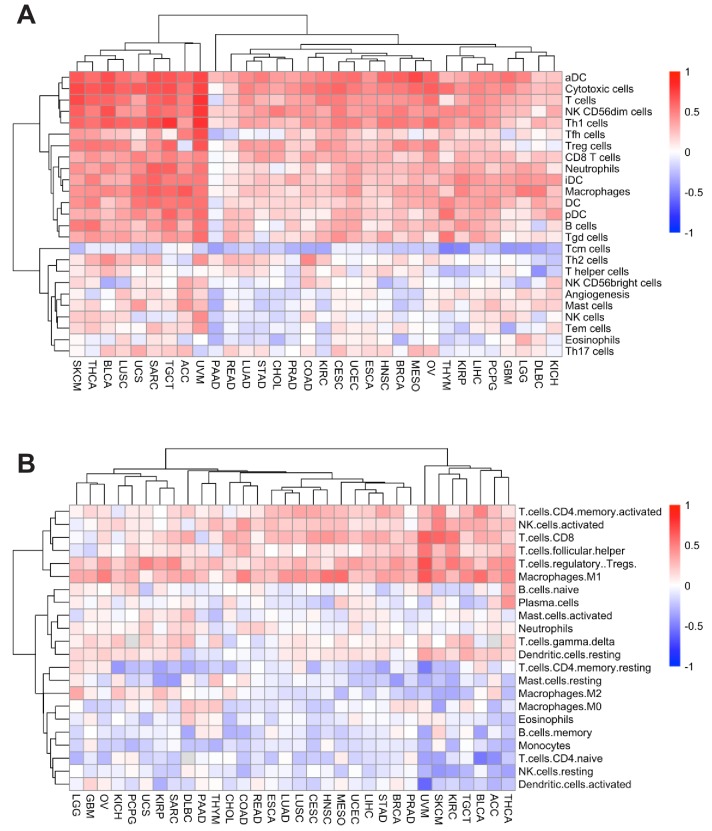
Immune cell subsets associated with APS were analyzed with IIS (A) or the CIBERSORT (B) method.